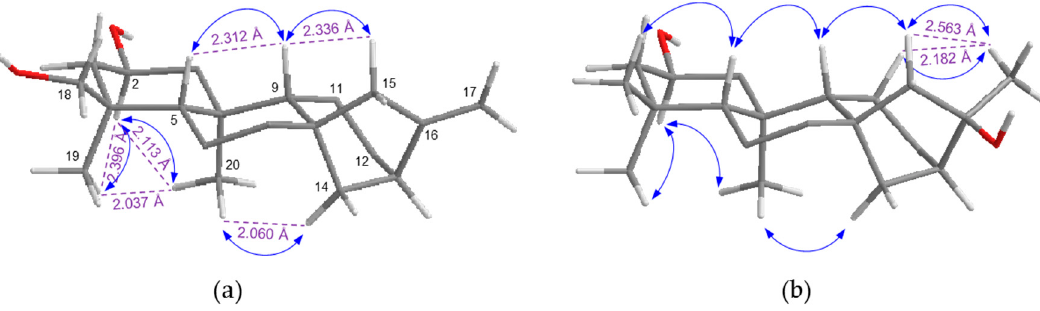
Figure 3. The NOESY correlations of each aglycone of compounds 4 ( a ) and 10 ( b ).